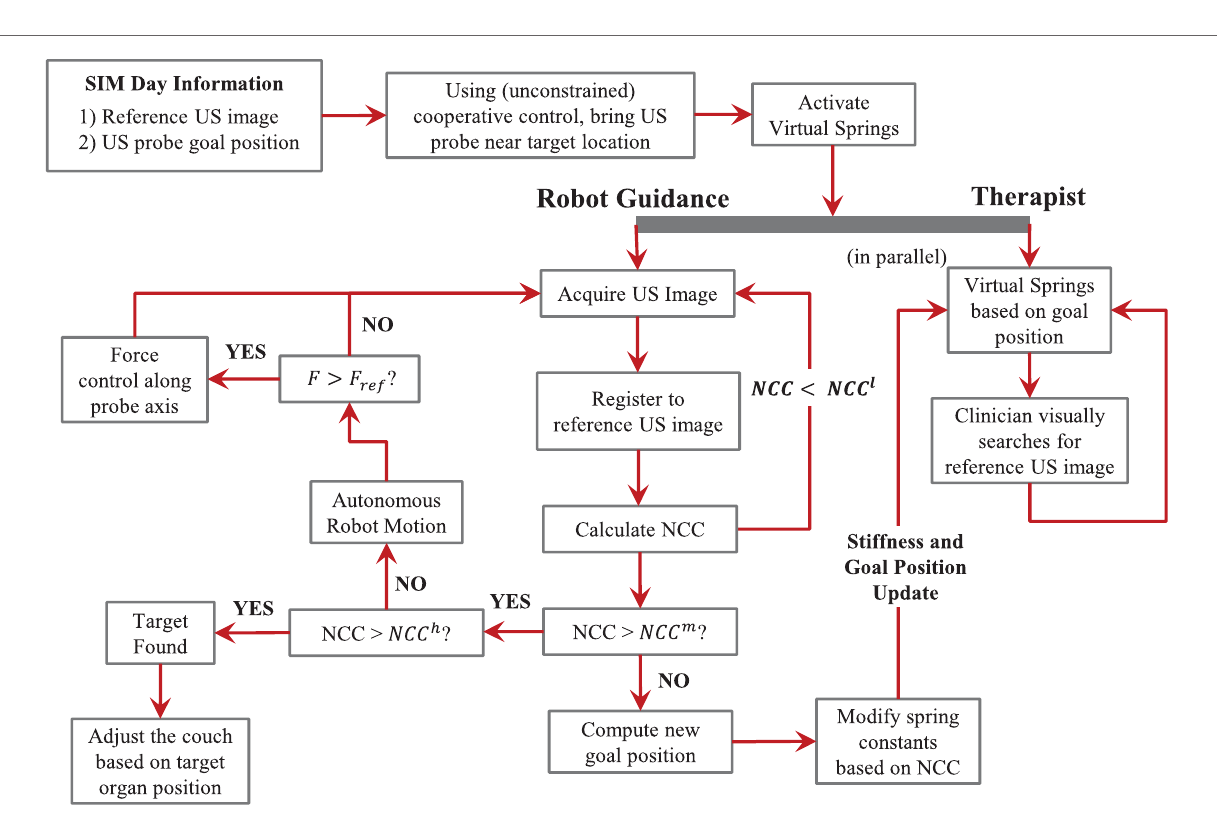
FIGURE 6 | Treatment day US probe placement process